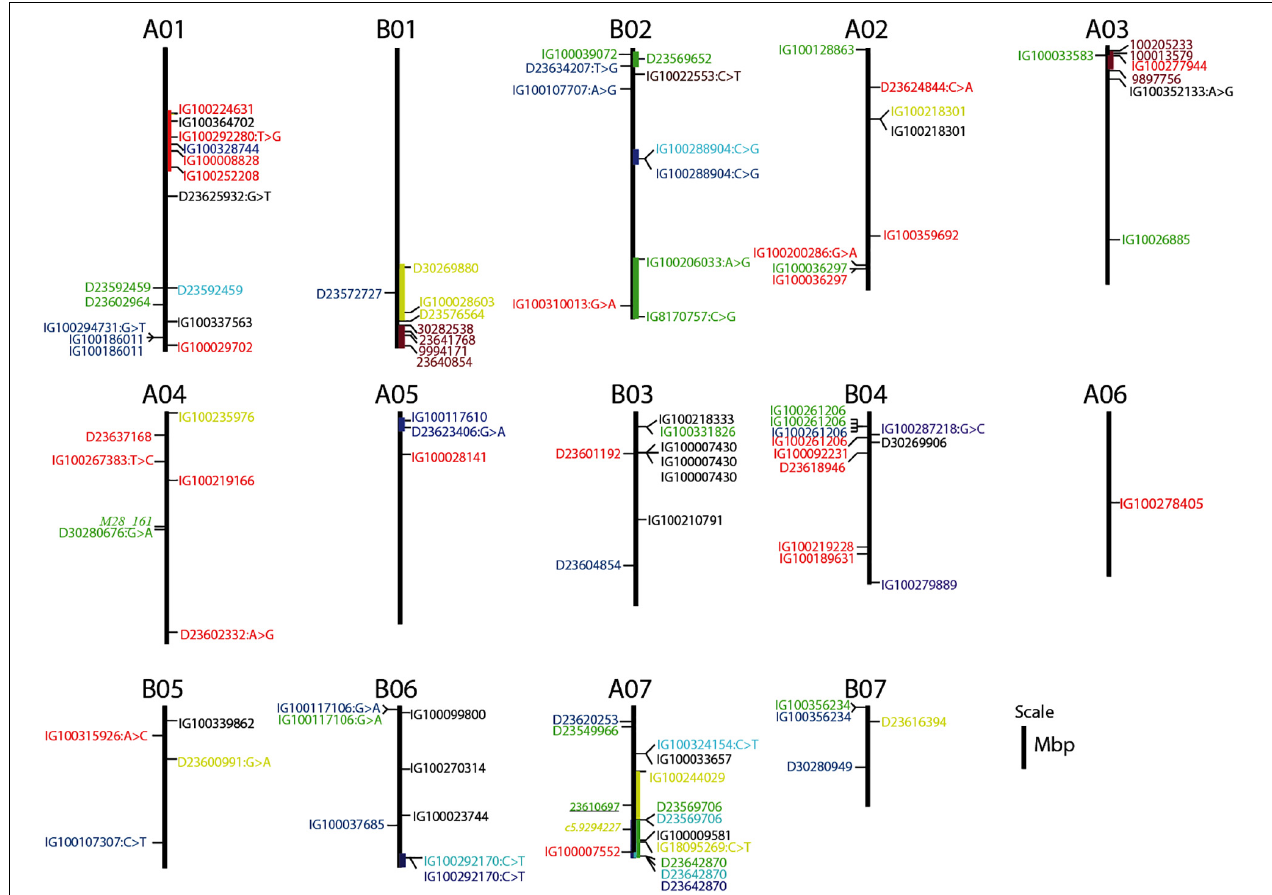
FIGURE 7 | Genomic map position of markers associated with QTLs governing the agronomic, morphological, and feed quality traits. Markers associated with the agro-morphological traits are shown to the right of the assembled chromosome (AC), while markers associated with the feed quality traits are shown to the left of the AC. Markers reported previously for Setaria italica (Jaiswal et al., 2019b; italicized) and pearl millet (Varshney et al., 2017; underlined) are also shown to the left of the AC. Markers strongly associated with TFW (total fresh weight), TDW (total dry weight), WUE (water use efficiency), PH (plant height), TN (tiller number), and PP (purple pigmentation) are shaded by green, light-blue, deep-blue, yellow, red, purple colors, respectively. Markers associated with traits that are affecting positively the feed nutritional quality (IVOMD, Me, and ash) are shaded green, while markers associated with traits linked with fiber and lignin components (ADF, ADL, and NDF) are shaded red. The markers associated with OM and DM are shaded